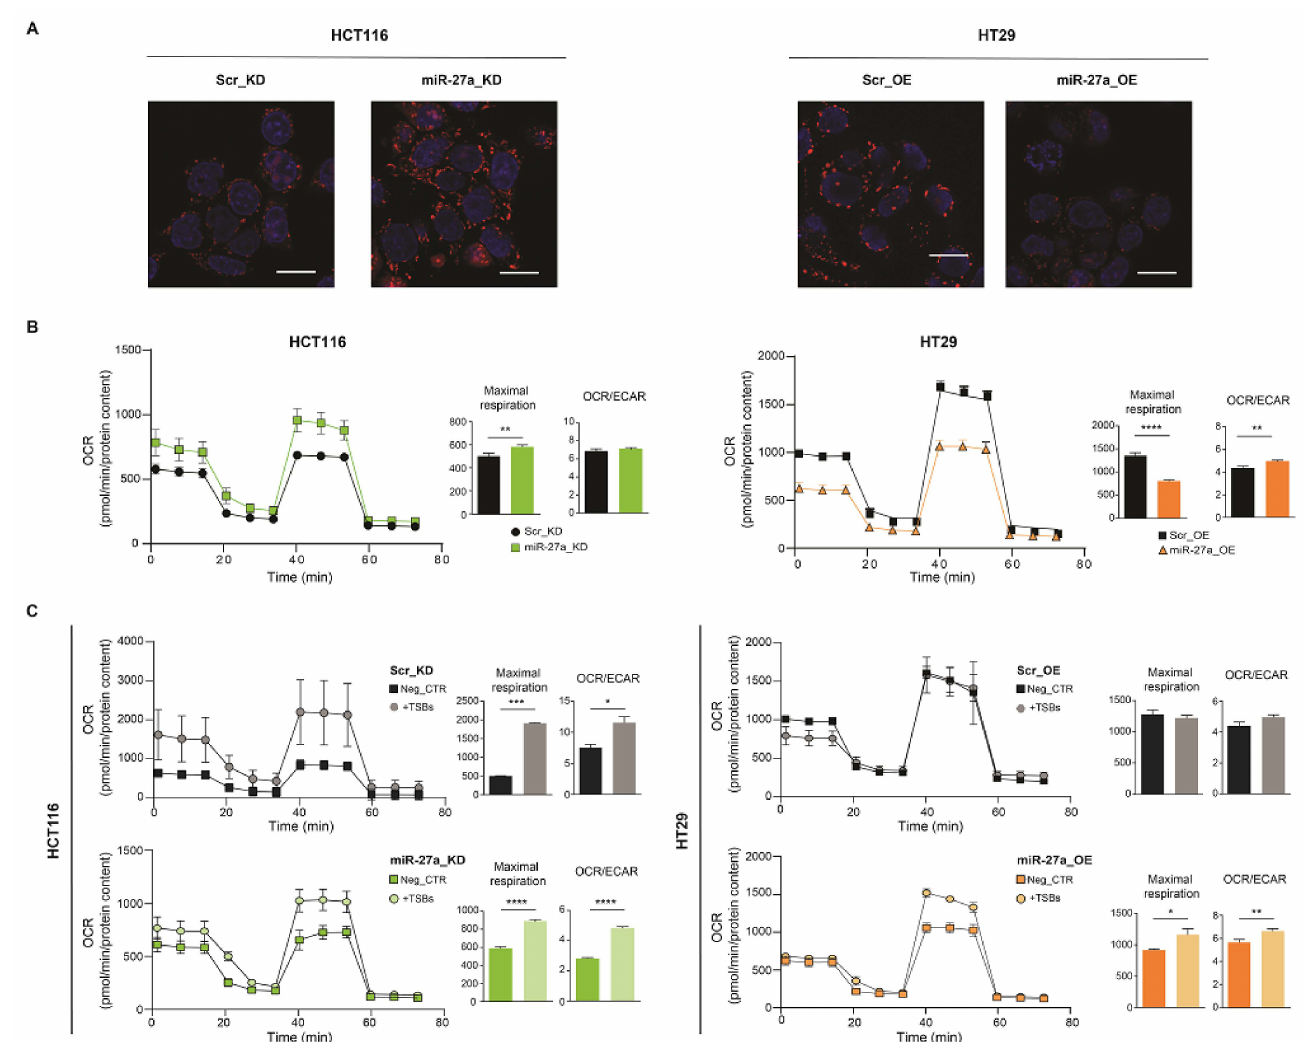
Figure 4. Mitochondrial superoxide production and OXPHOS activity are negatively regulated by miR-27a via FOXJ3. ( A ) Representative confocal microscopy images of the MitoSOX staining (red) of miR-27a_KD and miR-27a_OE, as well as relative Scr_KD and Scr_OE controls. Hoechst was used to stain nuclei (blue) (magnification: 63 × ; scale bar: 5 µ m). ( B ) Oxygen consumption rate (OCR) assay performed in the same cells as in ( A ) in basal conditions or ( C ) following transfection with the TSBs or the Neg_CTR. The histograms report the rates of maximal respiratory capacity and the OCR/ECAR ratios quantified upon the normalization of OCR to O.D. protein levels. Statistical significance was considered when * p ≤ 0.05, ** p ≤ 0.01, *** p ≤ 0.001, or **** p ≤ 0.0001 ( t